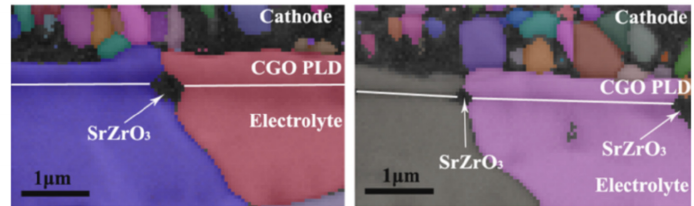
Figure 12. Electron backscattered diffraction image represents the typical migration behavior of segregated Sr from the surface of the cathode to form SrZrO 3 phase between the CeO 2 based barrier layer and the YSZ electrolyte. (Reproduced from Reference [70]. Copyright 2010 The American Ceramic